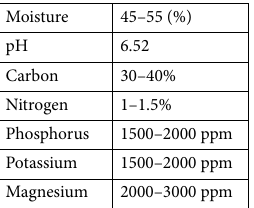
Table 1. Physicochemical properties of burial soil.